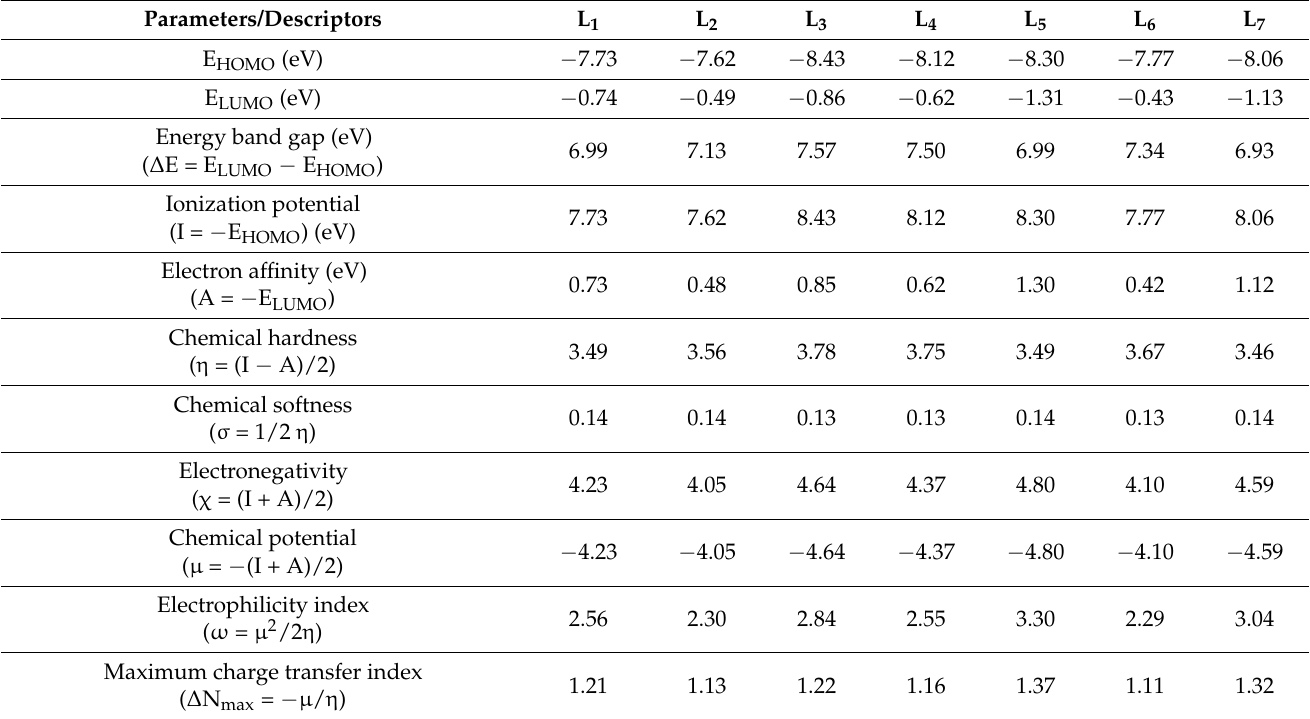
Table 2. The computed global reactivity descriptors for L 1–7